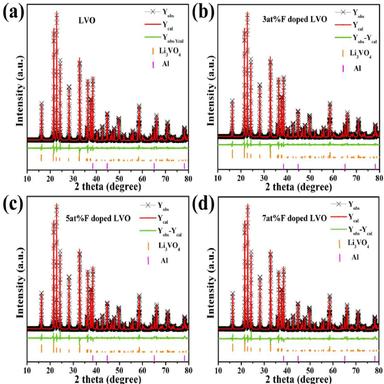
Rietveld refined XRD patterns for (a) pure LVO, (b) 3 at% F doped LVO, (c) 5 at% F doped LVO and (d) 7 at% F doped LVO.